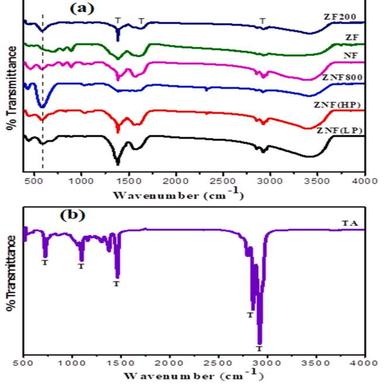
FT-IR spectra of as-synthesized ZNF(LP), ZNF(HP), ZNF800, NF, ZF and ZF200 samples (a) along with trioctylamine spectrum (TA) (b).